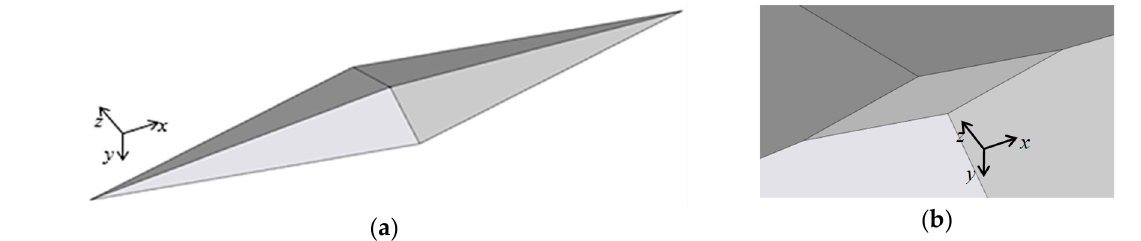
Figure 2. Knoop indenter modeled with Bezier surfaces: ( a ) general view; ( b ) detail of the indenter tip imperfection.